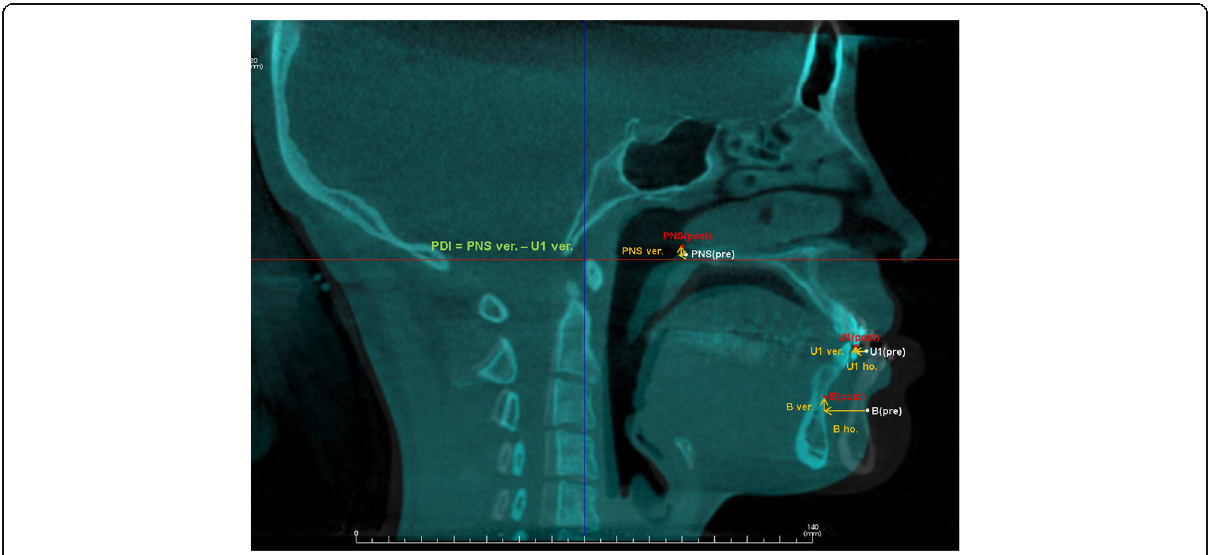
Fig. 4 Landmark measurements for surgical skeletal movements. The distances of maxillary and mandibular movements between prior to and after two-jaw surgery were measured at PNS, U1, and B point. U1 maxillary first molar root apices, B points innermost curvature from chin to alveo- lar bone junction, PNS posterior nasal spine, PDI posterior differential